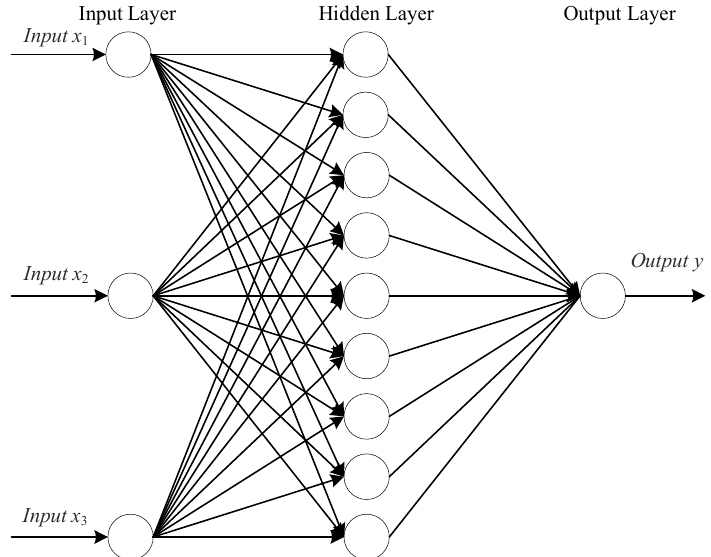
Figure 11. Back propagation neural network architectures.